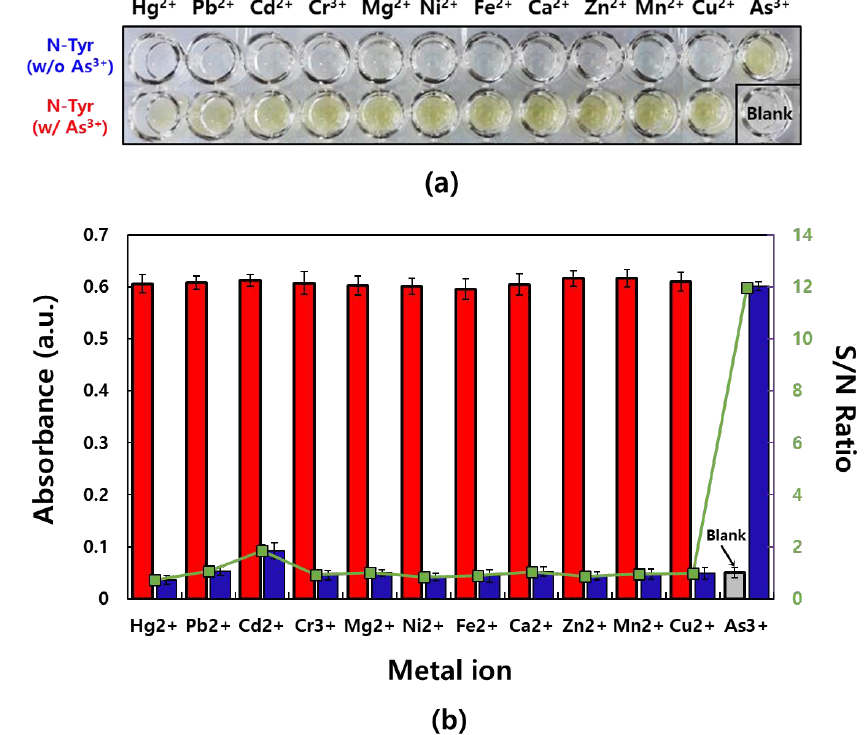
Figure 2. Reaction between N-Tyr and metal ions: ( a ) An image of two types of mixtures of metal ions and N-Tyr with or without As 3 + . ( b ) A graph of the absorbance values corresponding to the optical images ( n = 6). The absorbance of mixtures of N-Tyr and metal ions with (red) or without As 3 + (blue) are separately displayed. Also, the relationship between metal ion / N-Tyr mixture and N-Tyr solution are showed as an signal-to-noise (S / N) ratio with a secondary y -axis (green). The concentration of each material was 1 mM.